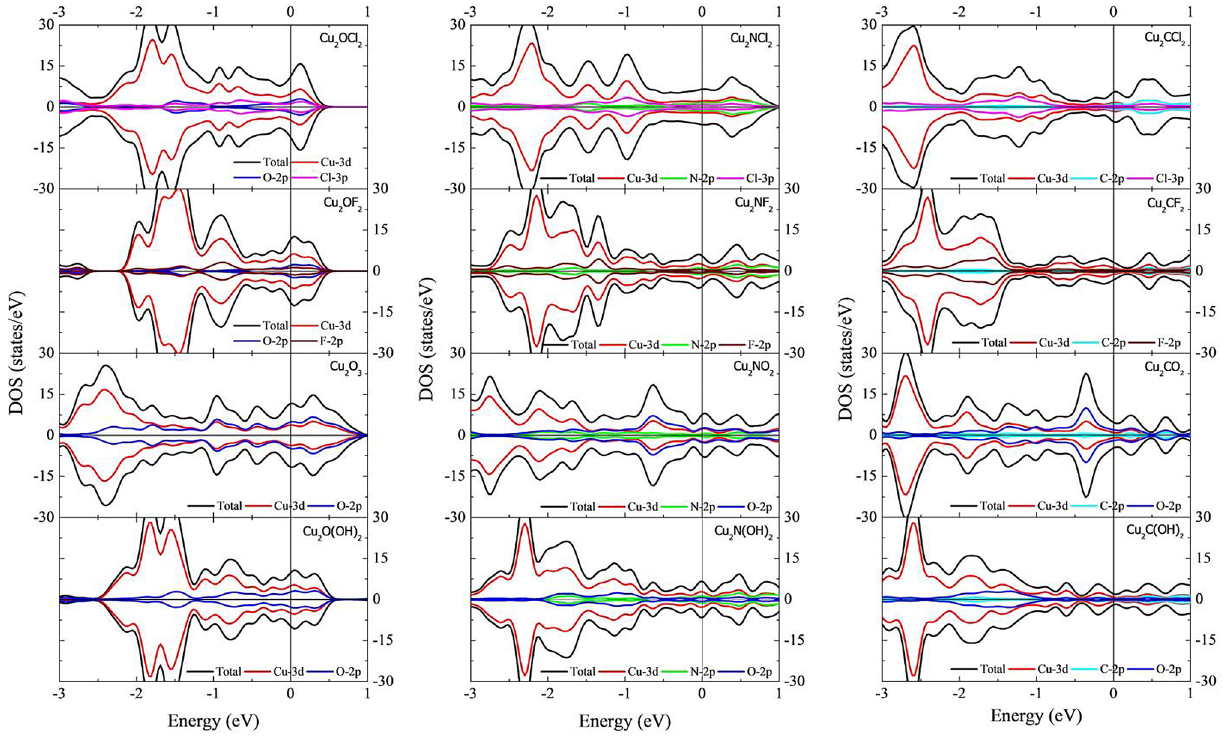
Figure 5. DOS and pDOS of the functionalized Cu 2 OT 2 , Cu 2 NT 2 and Cu 2 CT 2 (T = Cl, F, O, and OH)